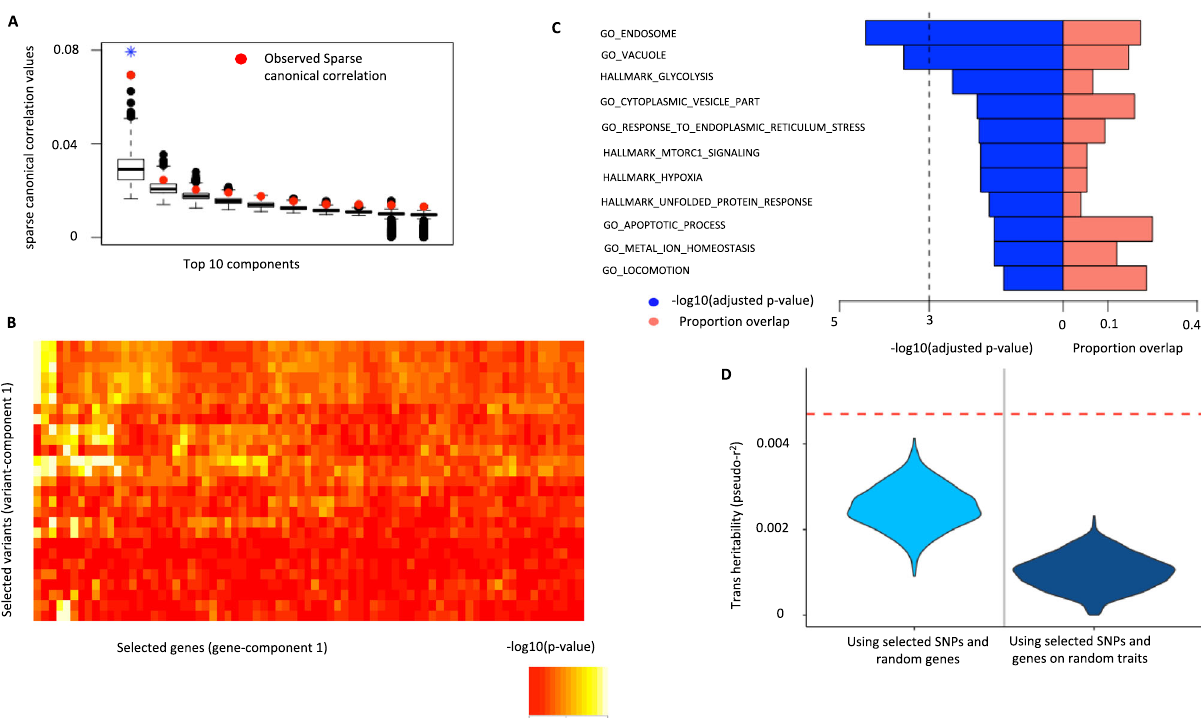
Fig. 3 Trans-association pattern and properties of selected target gene-set for Schizophrenia (SCZ). A Top 10 sparse canonical correlation values (cc- values; red) and the corresponding competitive null distributions (black box plot) for ARCHIE analysis of SCZ. Top 1 ARCHIE component is signi fi cant. The box plot for competitive null distribution is presented as ±1.5 interquartile range with the median line denoted at the center. The competitive null distribution denotes the general pattern of sparse canonical correlation (and trans-associations) expected in analysis of variants that are not speci fi c to SCZ. The signi fi cant ARCHIE components are marked by a blue asterisk. B − -log 10 ( p values) for standard trans-eQTL association test between variants and genes selected in ARCHIE component 1 as reported in eQTLGen (two sided test). Any association p value < 10 − 08 is collapsed to 10 − 08 for the ease of viewing. C Pathway enrichment results for some selected top pathways for the target genes selected in gene-component 1. For full pathway enrichment results for the target genes selected see Supplementary Data 3, 4. The dashed vertical line corresponds to a suggested FDR threshold of 0.001. D trans- heritability enrichment analysis for target genes selected for SCZ. The violin plots represent the distribution of pseudo-r 2 for the selected SNPs and a random gene-set of the same size on SCZ (left) and the distribution of pseudo-r 2 of the selected genes and SNPs on a random trait in UK Biobank (right). The red dashed line represents the observed pseudo-r 2 for the selected SNPs and target genes for SCZ (See Results and Methods for details).